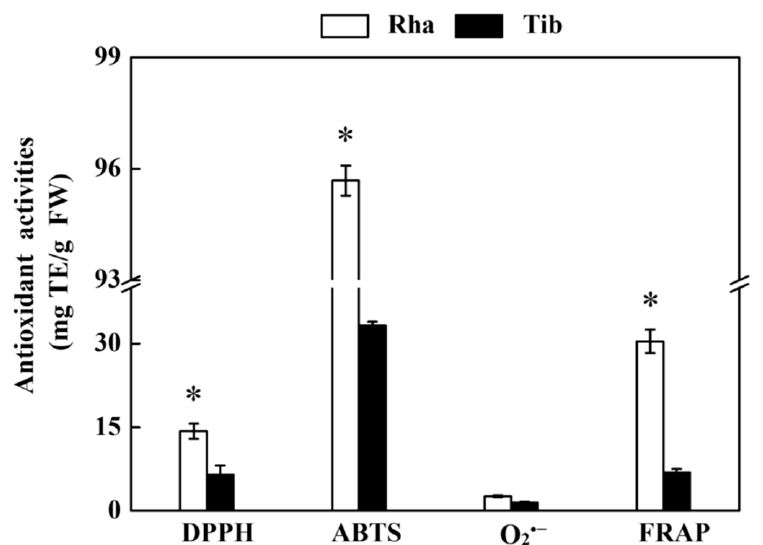
Figure 6. In vitro antioxidant activities of Rha and Tib berries. Vertical bars represent standard error of the mean ( ± SE), and the “*” indicate significant differences at p < 0.05.